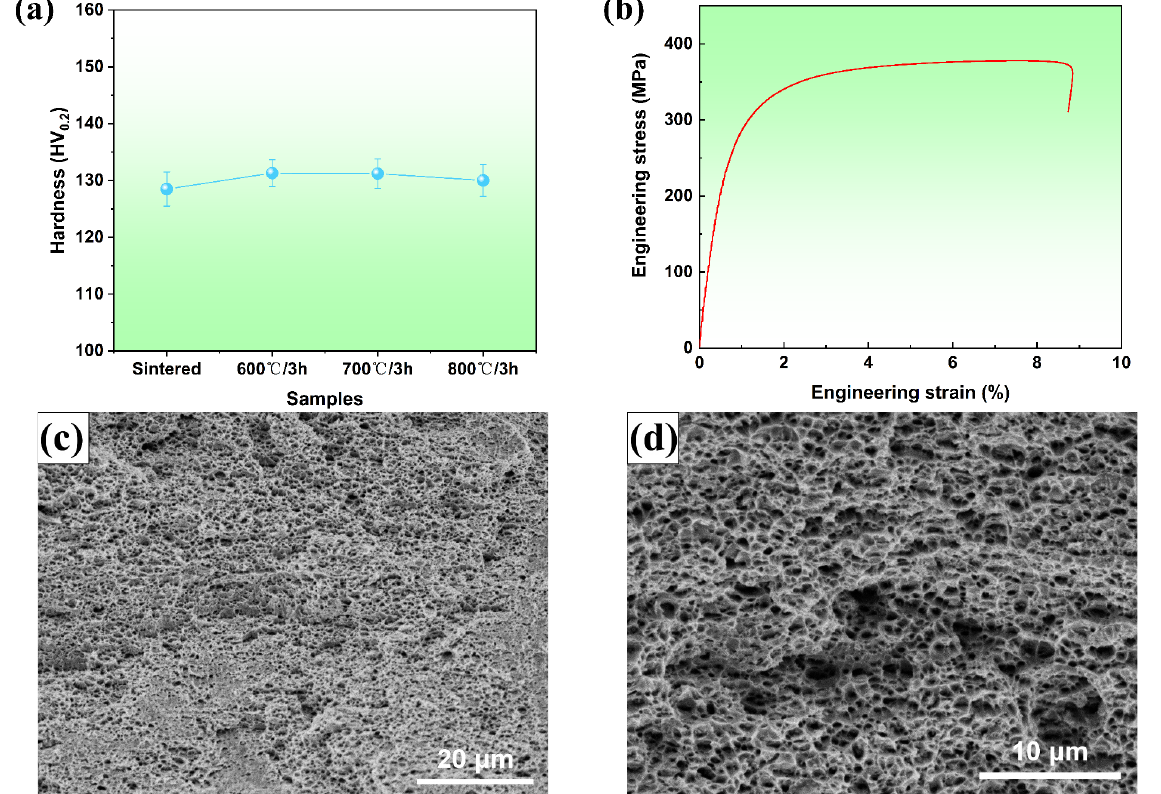
Figure 9. ( a ) Hardness of the sintered and annealed alloys; ( b ) engineering stress–strain curve of the alloy annealed at 800 ° C; ( c , d ) tensile fracture morphologies of the alloy annealed at 800 ° C.